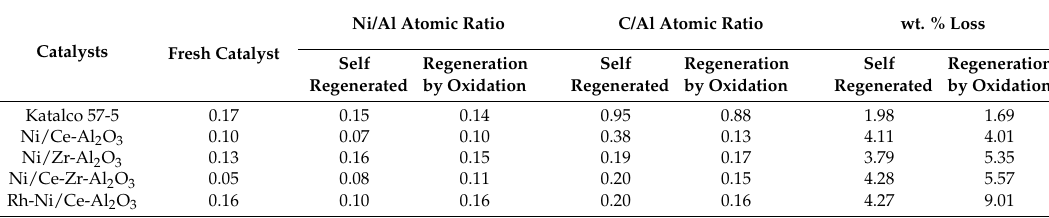
Table 3. Ni/Al and C/Al atomic ratios measured by X-ray photoelectron spectroscopy (XPS) and total weight loss (wt. %) measured by TGA. Self-regenerated samples were analyzed after stable operation of the last tri-reforming process. Samples of regeneration by oxidation were analyzed after the last H 2 S